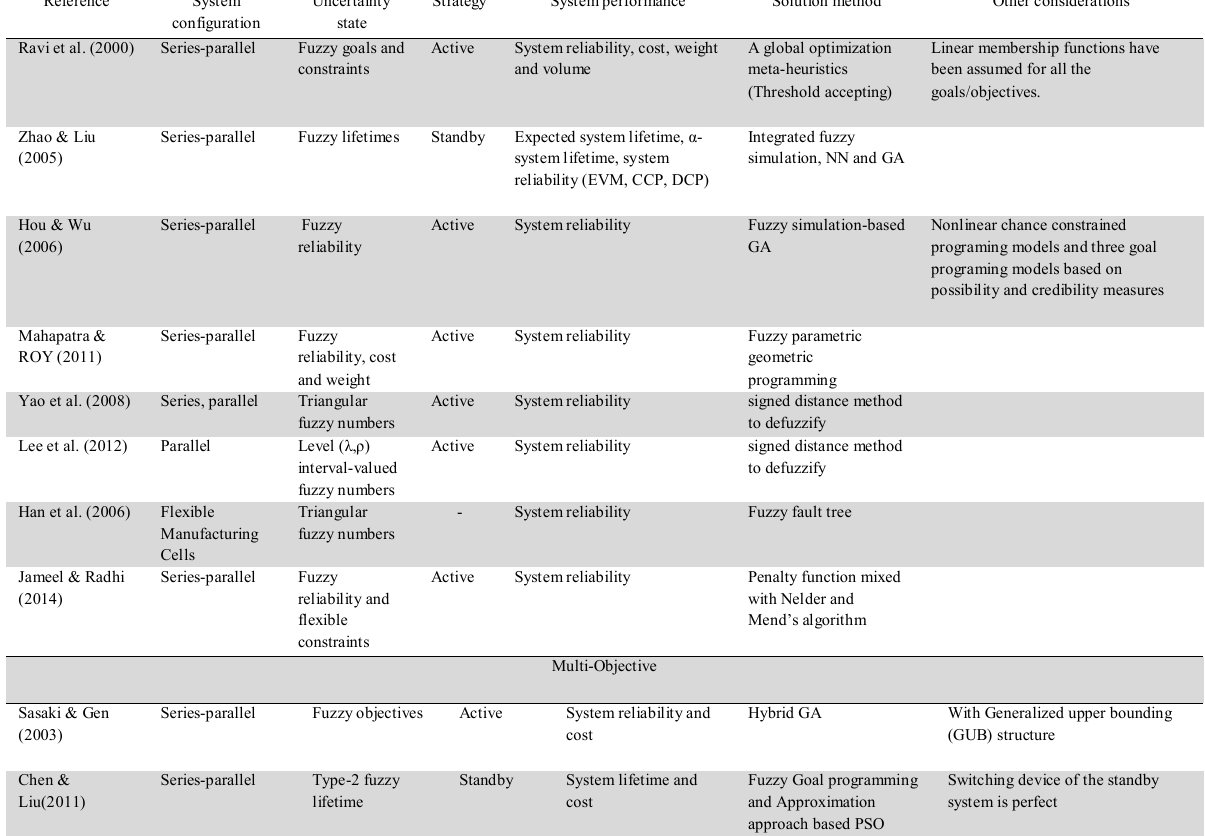
Fuzzy uncertainty